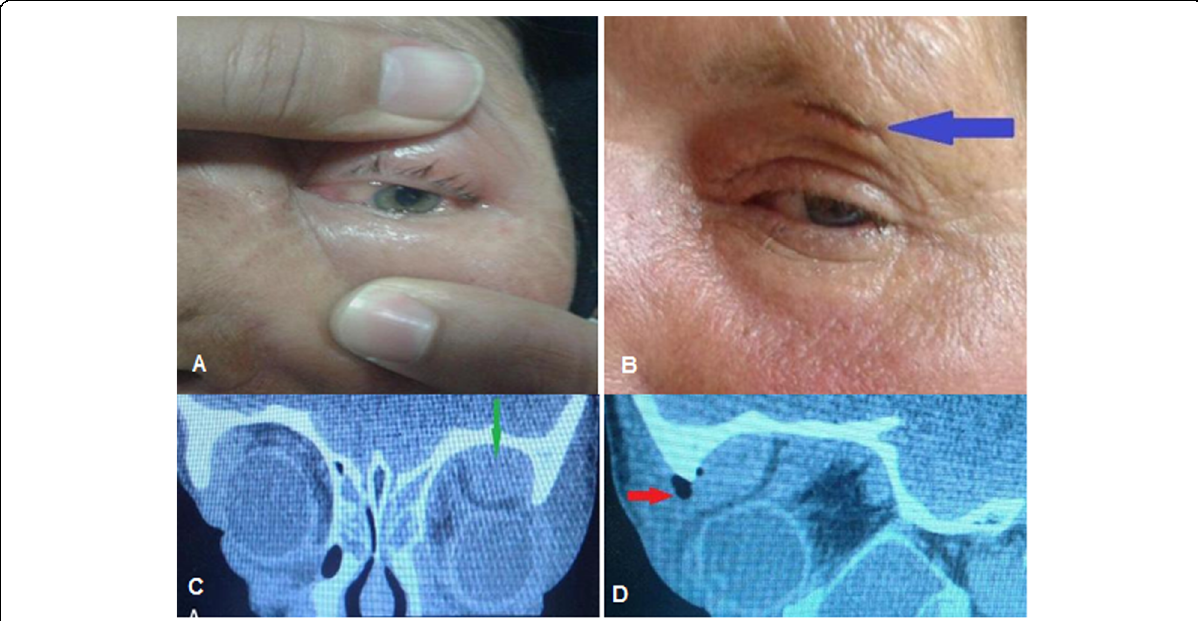
Fig. 7 A 62-year-old woman with visual impairment in presenting time, a external eye exam shows upper lid swelling and redness with limitation of motion and conjuctival chemosis, b 5 day after external abscess drainage with sub-brow incision (blue arrow), c orbital CT scan coronal view revealed a left supra-temporal subperiostal abscess (green arrow), d and sagittal view showed a superior abscess with hypodense area (red